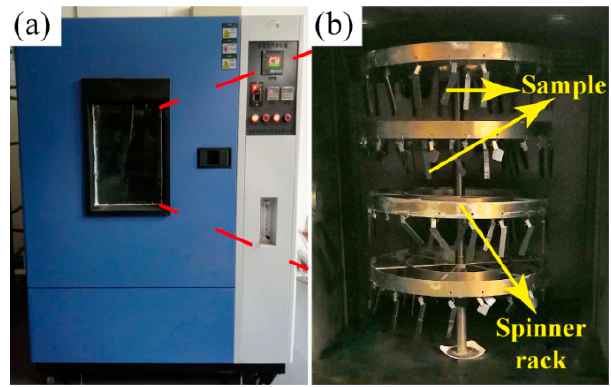
Figure 3. The air-circulating oven: ( a ) The outer of the air-circulating oven, and ( b ) the state of samples in the air-circulating oven.